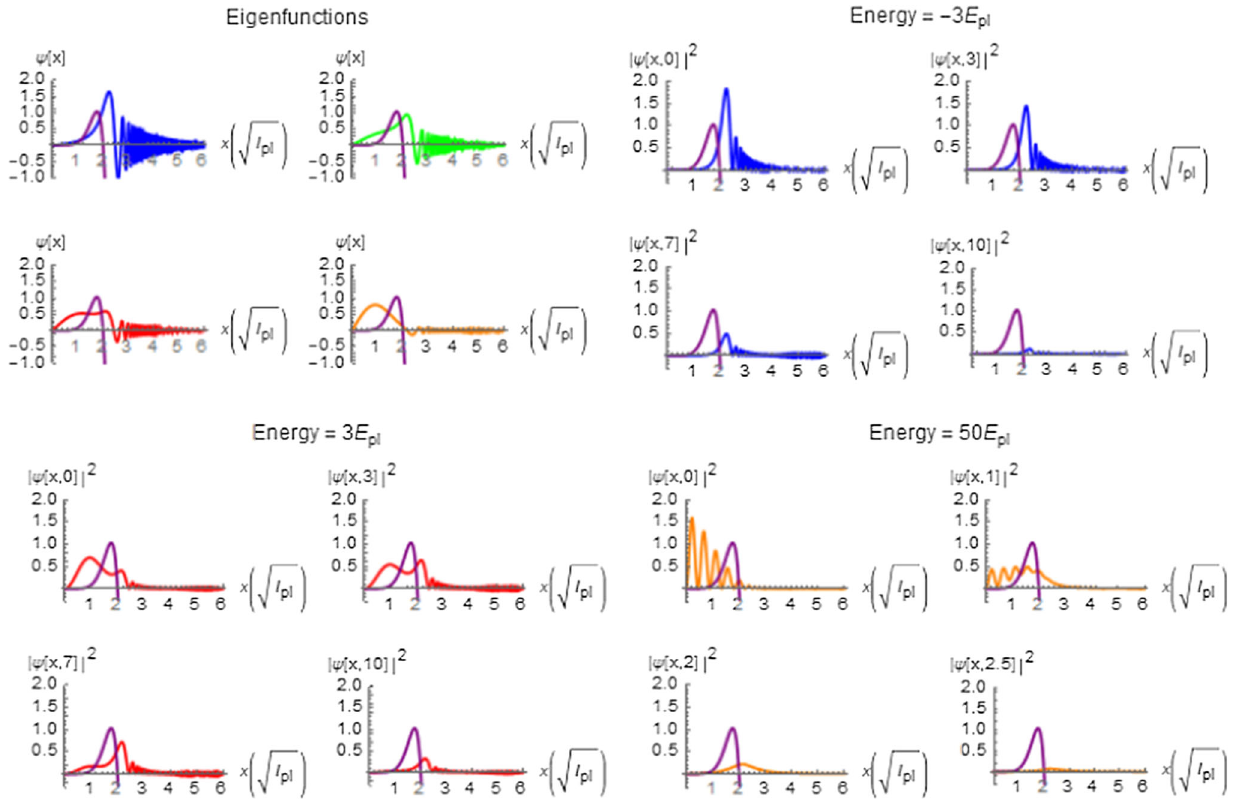
Fig. 4 The panel shows the numerical analysis done for the quantum FRWmodel.ThefirstfigureshowsthesolutionoftheSchrödingerequa- tion (31) taken for different energy eigenvalues: E = − 3 E pl , E = E pl , E = 3 E pl and E (cid:10) V Max = 50 E pl .Then,intheotherthreefigures,the